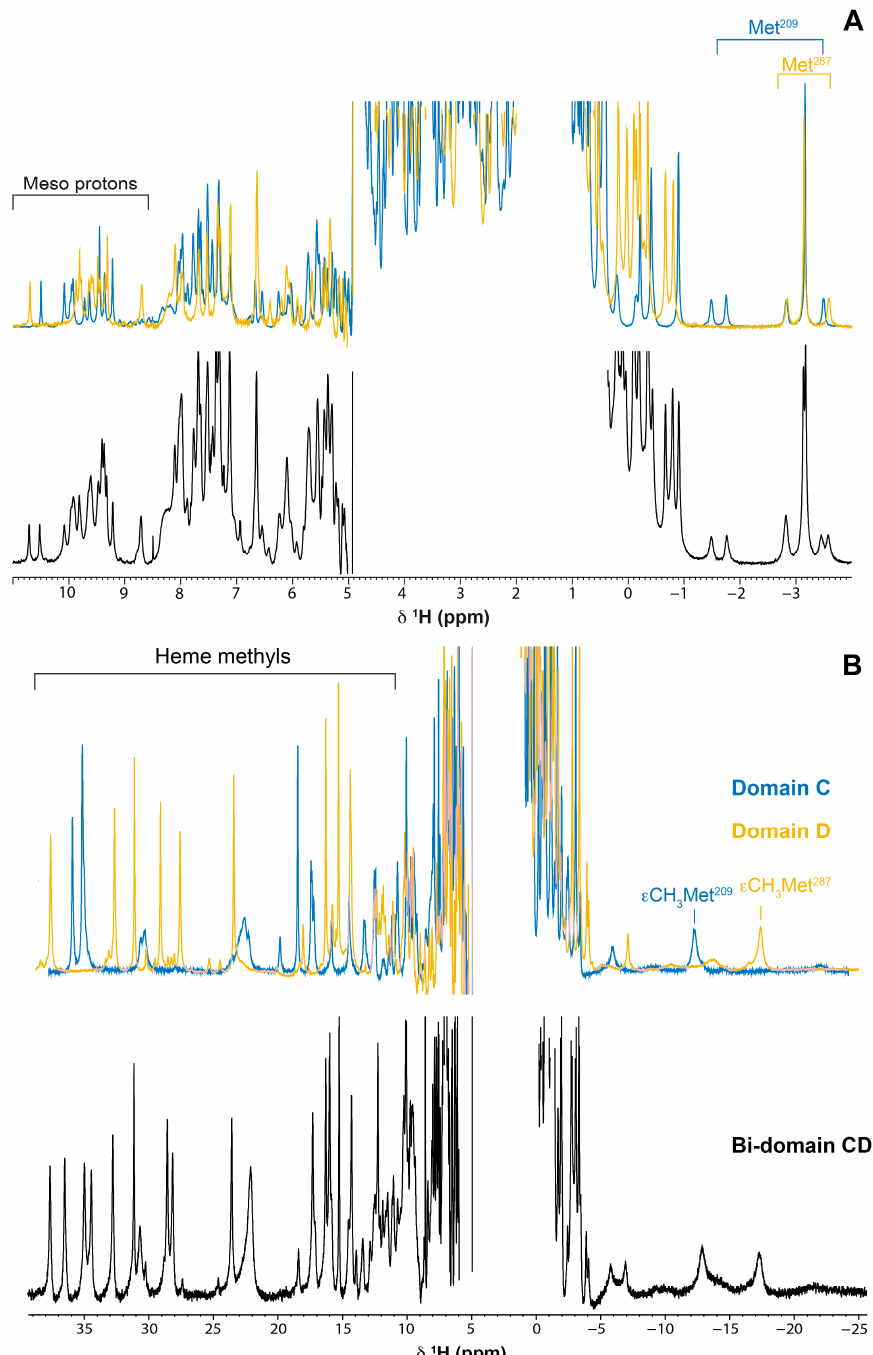
Figure 3. 1D 1 H-NMR spectra of domain C, domain D and bi-domain CD in the reduced ( A ) and oxidized state ( B ). The spectra of domains C and D are represented in the top of each panel in blue and yellow, respectively. The bottom spectrum in each panel correspond to bi-domain CD. The typical regions for meso and methyl signals are indicated in the reduced and oxidized spectra, respectively. The axial methionine spectral signatures are indicated in the reduced spectra of domains C and D. The signal correspondent to the group of ε CH 3 of each axial methionine is also indicated in proton frequency of 600